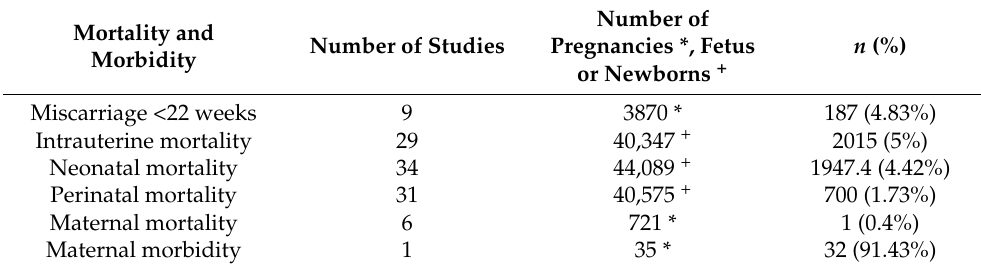
Table 6. Mortality and morbidity results of the triplet pregnancies included in the systematic review. Mortality